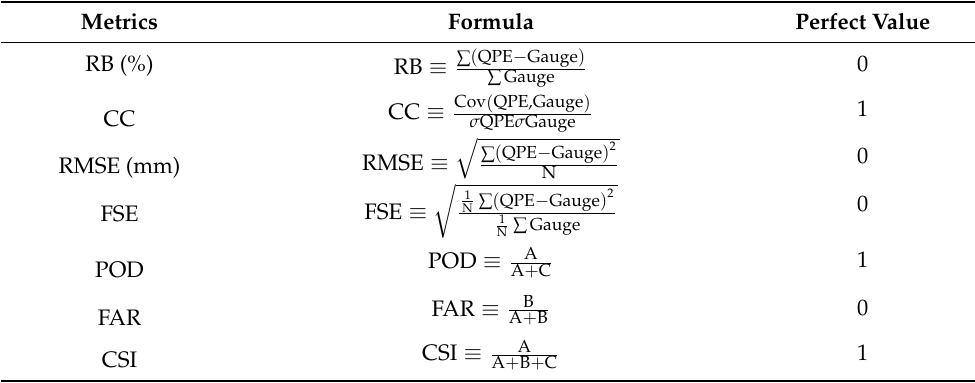
Table 2. Statistical evaluation metrics.